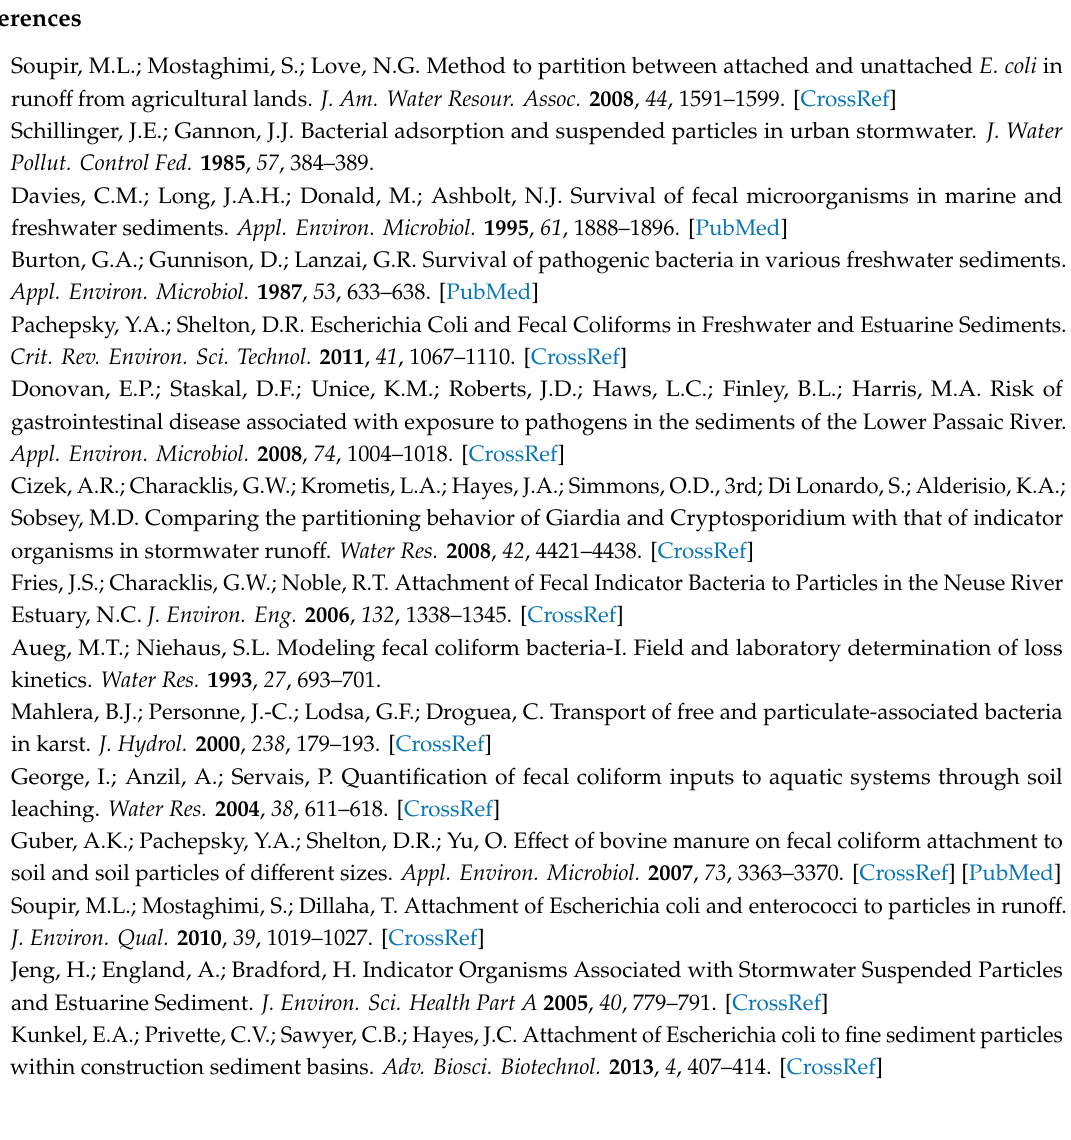
Figure S1: E. coli flux measurement and results. ( a ) Picked positions for measuring E. coli flux in the cross-section of the channel. ( b ) The cumulative average of E. coli flux at selected positions, Figure S2: Scanning electron microscope (SEM) micrographs of glass microspheres. ( a ) 10 µ m microspheres at low magnification ( × 10k); ( b ) 10 µ m microspheres at high magnification ( × 30k); ( c ) 20 µ m microspheres at low magnification ( ×